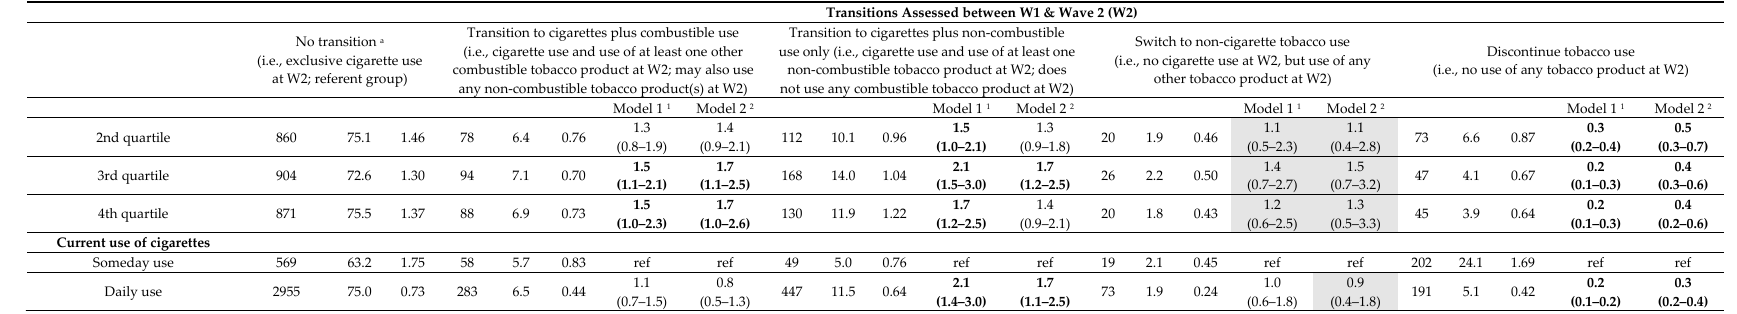
Table 3. Cont. Int. J. Environ. Res. Public Health 2018 , 15 , x 13 of 21 Transitions Assessed between W1 & Wave 2 (W2)